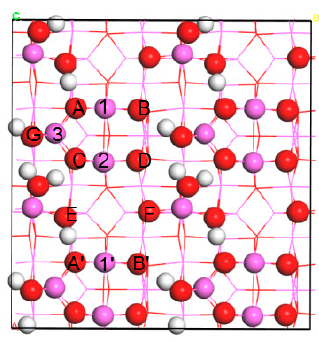
Figure 1. Top view of hydrated γ -Al 2 O 3 (110) surface with 5.9 OH/nm 2 . Atoms in the first layer and other layers are displayed in sphere and line forms, respectively. White: H, red: O, and pink: Al.